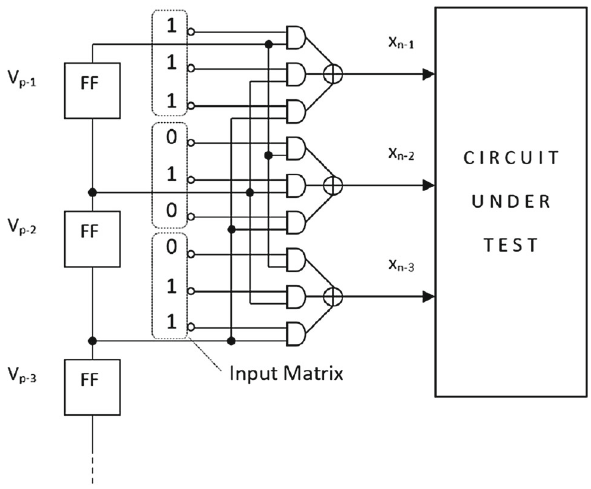
matrix free long Fig. 8 Input matrix connection schema